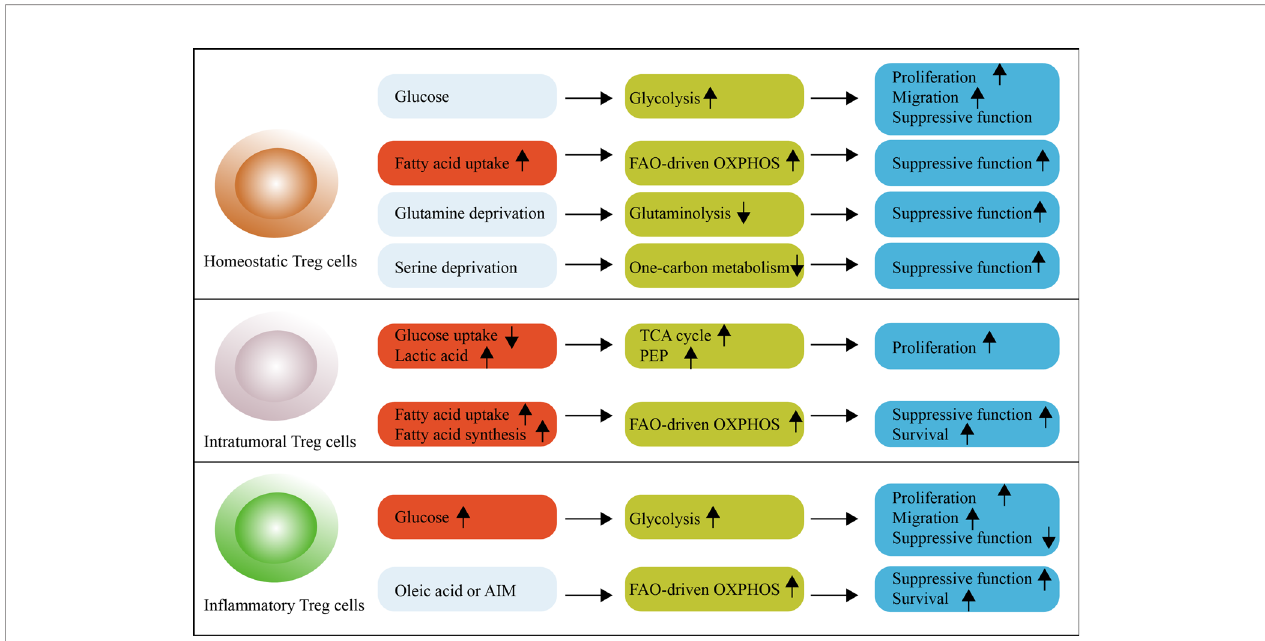
FIGURE 1 | An overview of metabolic reprogramming in Treg cells. Glycolysis is engaged to fuel the proliferation and migration of Treg cells, but is associated with reduced suppressive function and long-term instability in mice. Glycolysis is required for the proliferation, differentiation and suppressive function of human Treg cells. Treg cells increase the reliance on OXPHOS and FAO. Under homeostatic conditions, Treg cells readily take up exogenous fatty acids for this purpose. Serine-driven one-carbon metabolism and glutamine-driven glutaminolysis are not necessary for Treg cells because their absence promotes the differentiation and function of Treg cells. Intratumoral Treg cells use lactic acid to feed the TCA cycle and generate PEP to fuel proliferation. These cells reprogram lipid metabolism by upregulating lipid uptakeand denovo lipid synthesisto support FAO-driven OXPHOS metabolism. In autoimmune diseases, in fl ammatoryTreg cells exhibit a dysfunctional suppressive function, which can besupported byhighlevels of glycolyticmetabolism. Oleicacid counteracts this effect. The OXPHOS of lipidscan also bepromoted bythe DNA-binding in fl ammasome receptorAIM.FAO,fatty acid oxidation; OXPHOS, oxidative phosphorylation;PEP, phosphoenolpyruvate; TCA cycle, tricarboxylicacid